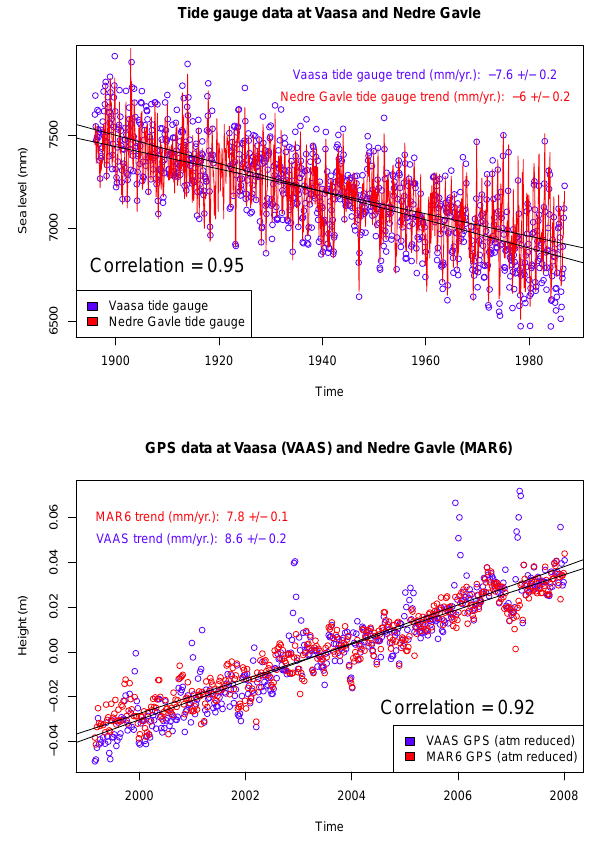
Fig. 8. The correlation of the height time series of two tide gauges Fig. 7. The upper panel shows the correlation in height trend of two tide gauges Vaasa and Nedre Gavle, located on opposite sides of the Vaasa and Nedre Gavle (the upper panel) situated on the opposite GulfofBothniaatapproximately340kmdistance. Thelowerpanelshowsthecorrelationbetweentheirco-locatedGPSstations,VAASand sides of the Gulf of Bothnia at approximately 340km distance. The correlation of the height time series of their co-located GPS stations, VAAS and MAR6 (with atmospheric loading correction applied, the lower